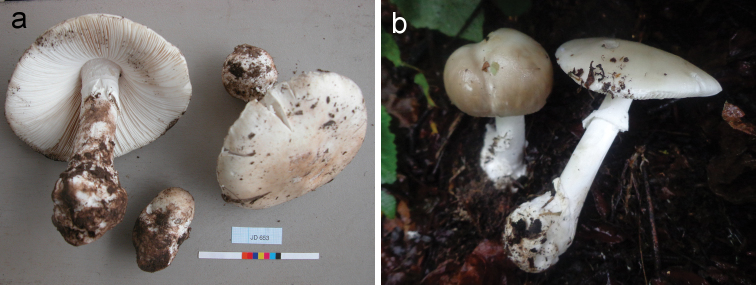
Basidiomata of Amanitabweyeyensis. a Degreef 653 b Degreef 1257.